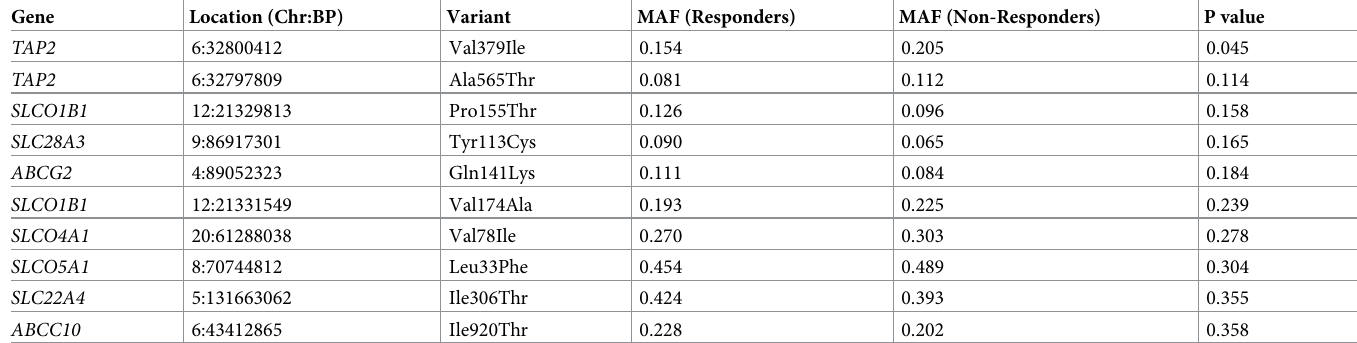
Table 2. Strongest associations for common transporter gene variants with response to mesalamine. P values are represented in table were calculated by Chi square analysis with threshold for significance of 0.0013 to correct for multiple testing.